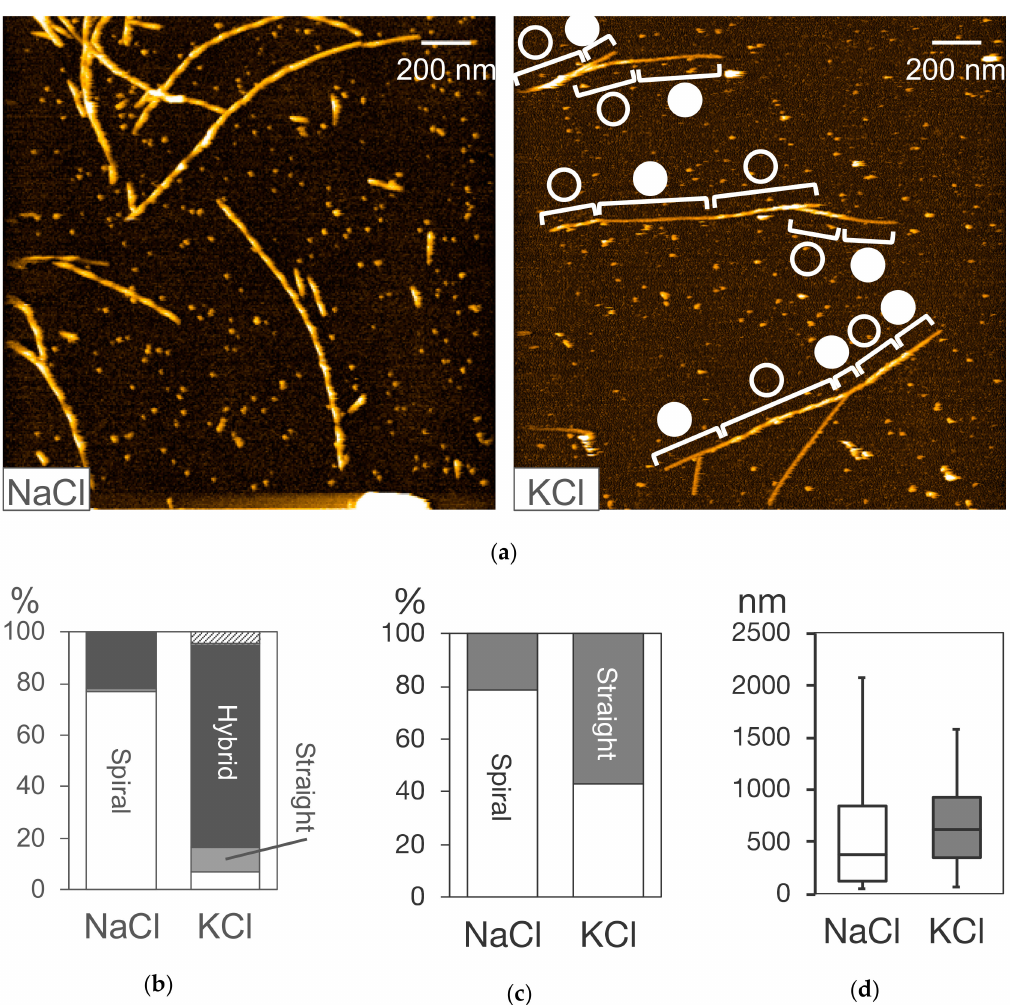
Figure 3. HS-AFM observation of fibril elongation from LMW A β 42 incubation on mica surface in 10 mM sodium phosphate, pH 7.4 titrated with 0.1 M NaCl, or KCl. ( a ) HS-AFM images of A β 42 fibrils approximately 1 h after the addition of NaCl or KCl as indicated. The spiral and straight parts in the hybrid-type fibrils are indicated by open and closed circles. ( b – d ) Distributions of the fibril type ( b ), the growth mode ( c ), and the fibril length ( d ) under NaCl and KCl conditions. The top hatched portion for KCl in ( b ) indicates the fibrils whose structure was not determined due to their length being shorter than the spiral pitch. Reproduced from [93] except for the image in NaCl shown in ( a